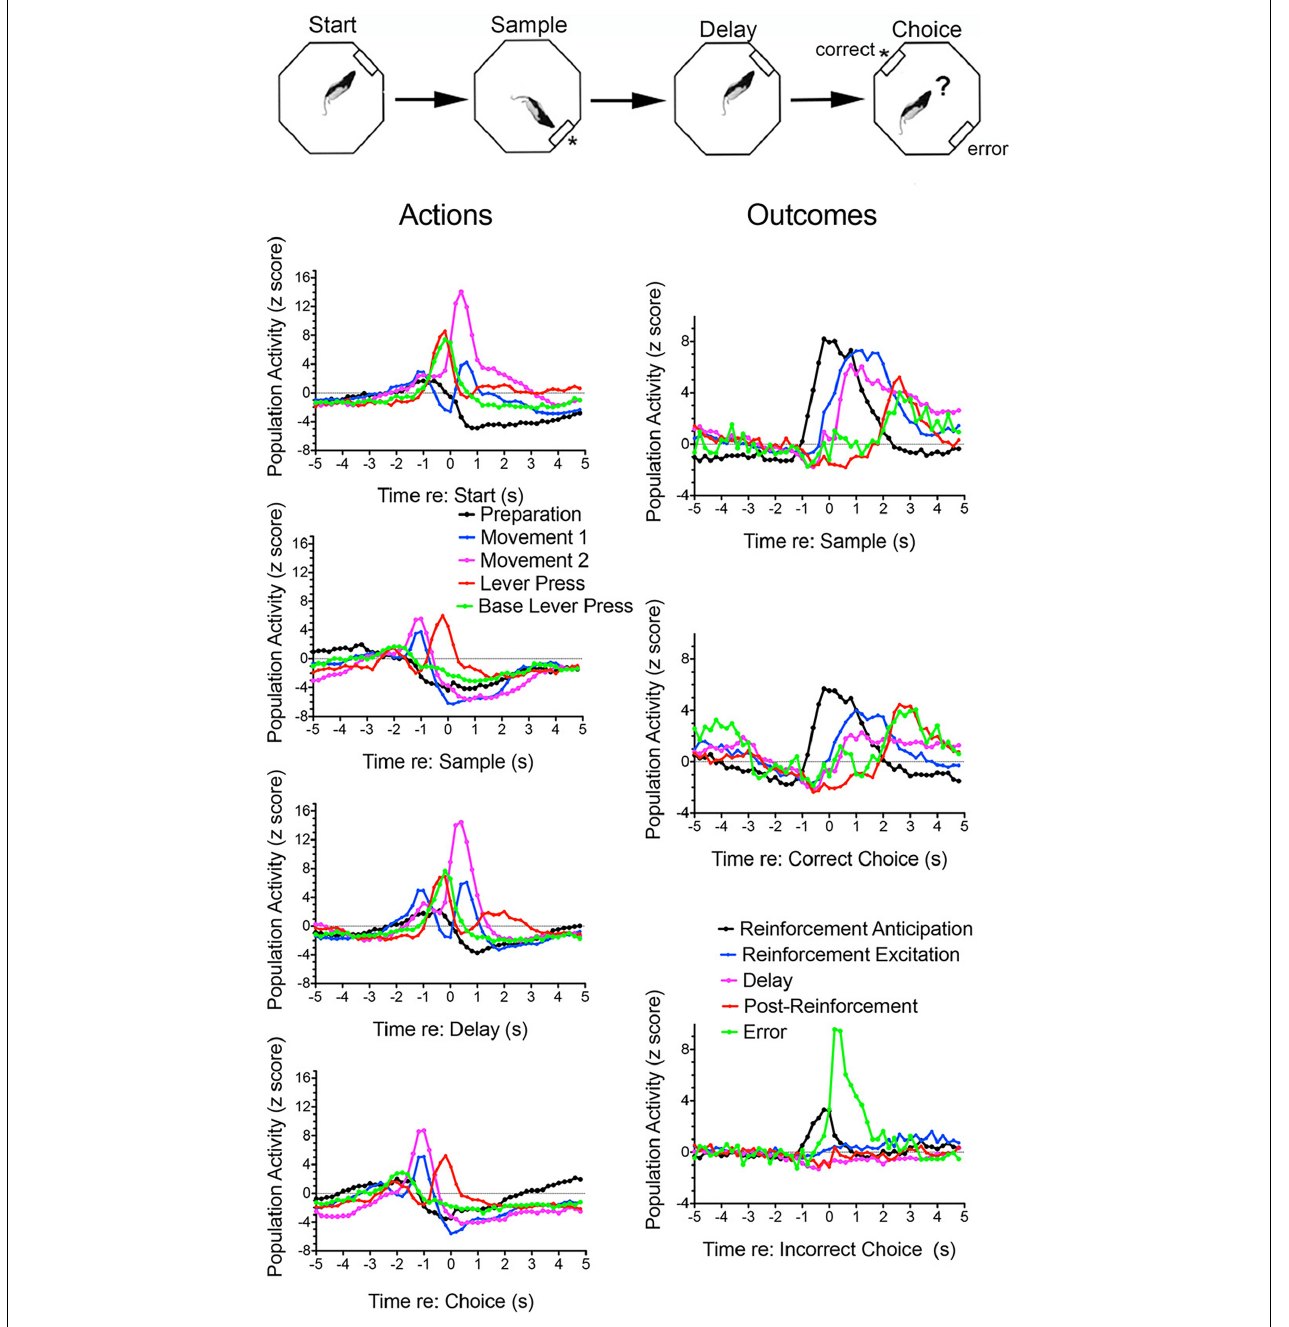
FIGURE 1 | Normalized population histograms for response types observed in mPFC for rats performing the dynamic DNMTP task. The task is illustrated above. Trials begin with a randomly selected lever extending at one of four possible locations (90 ◦ apart) for the start response. The start lever retracted when pressed and a lever was then extended 90 ◦ to the left or right (randomly selected) of the start lever. This retracted when pressed and water reinforcement delivered (indicated by asterisk) through a spout immediately above the lever. The initial lever was then reinserted for the delay response. This was retracted with the first press after the memory delay ended and levers 90 ◦ to the left and right inserted for the choice. These both were retracted when either one was pressed and reinforcement delivered when the lever not extended for the sample was the one pressed (a correct non-matching response). Results are shown for all neuronal responses recorded for each response type with a minimum of 40 trials completed in a 60 m session. These were averaged for individual neurons and normalized so that each response recorded contributed equally to the population function. Error bars represent standard error of the mean. Results are shown for preparation ( n = 44), movement 1 (before all lever presses, n = 97), movement 2 (toward reinforced lever presses, n = 32), lever press ( n = 28), base lever press (start and delay presses only, n = 30), reinforcement anticipation (preceding delivery, n = 50), reinforcement (following delivery, n = 63), delay ( n = 58), post-reinforcement (when rats disengaged from spouts, n = 16), and error ( n = 4). These population histograms were previously published online (Francoeur and Mair, 2018). ? Represents choice.